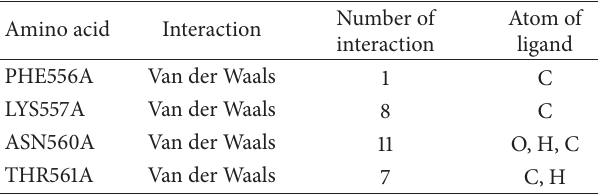
Table 3: Interactions of AEC reference ligand with protein